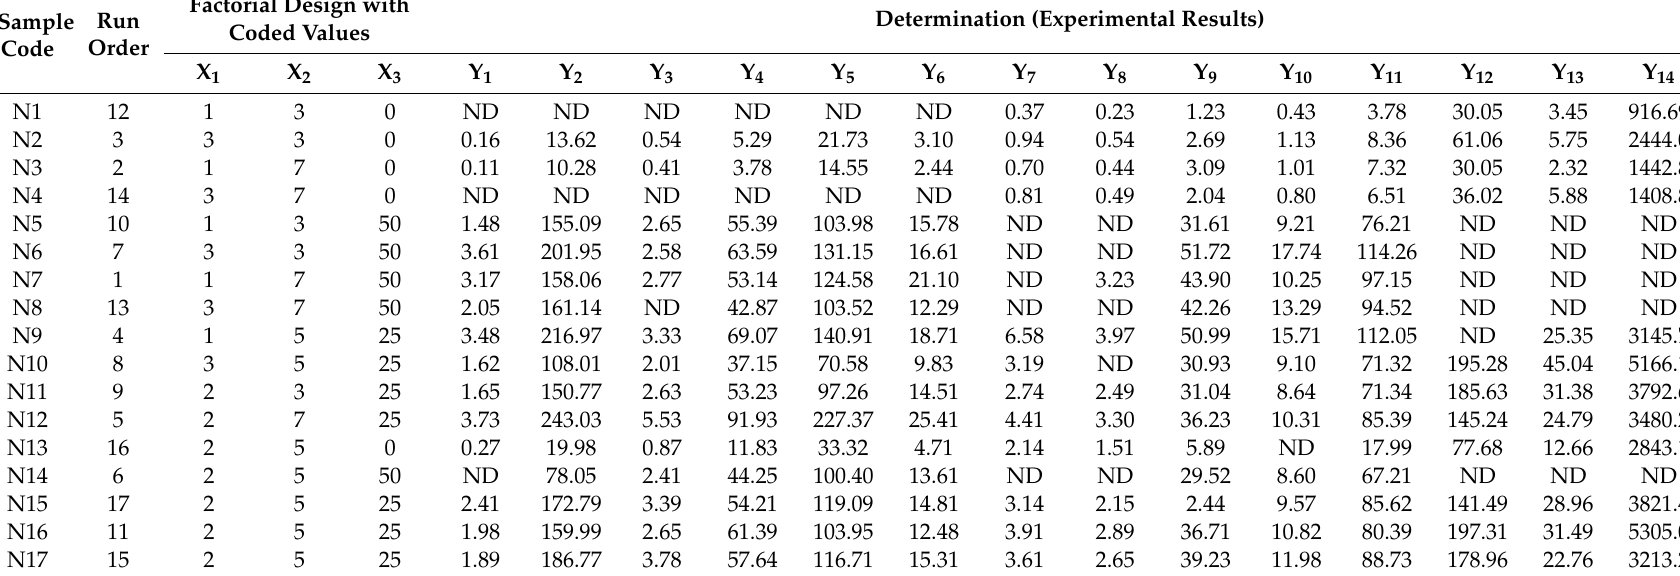
Table 5. Matrix of experimental design and results for bioactive compound recovery from hazelnut involucre